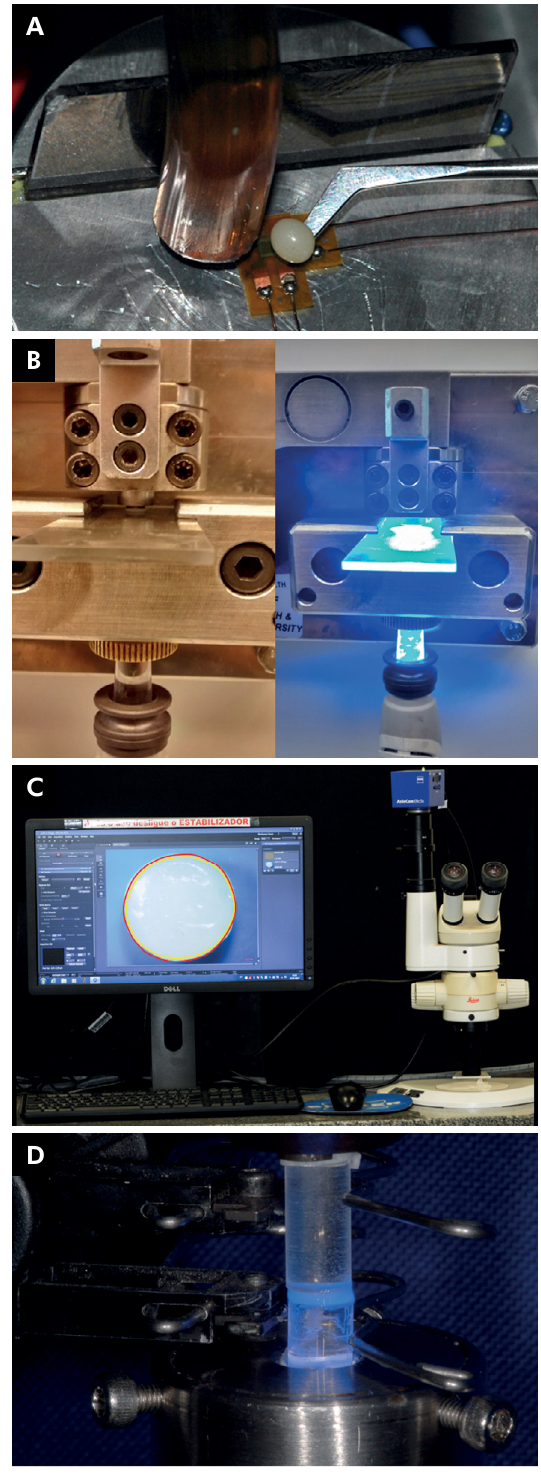
Figure 3. Experimental methods used for measuring polymerization shrinkage effect – A. Strain-gauge test for measuring post-gel shrinkage; B. Bioman for measuring shrinkage force; C. Optical method for measuring total shrinkage; D. Contraction stress using set-up with two opposing glass